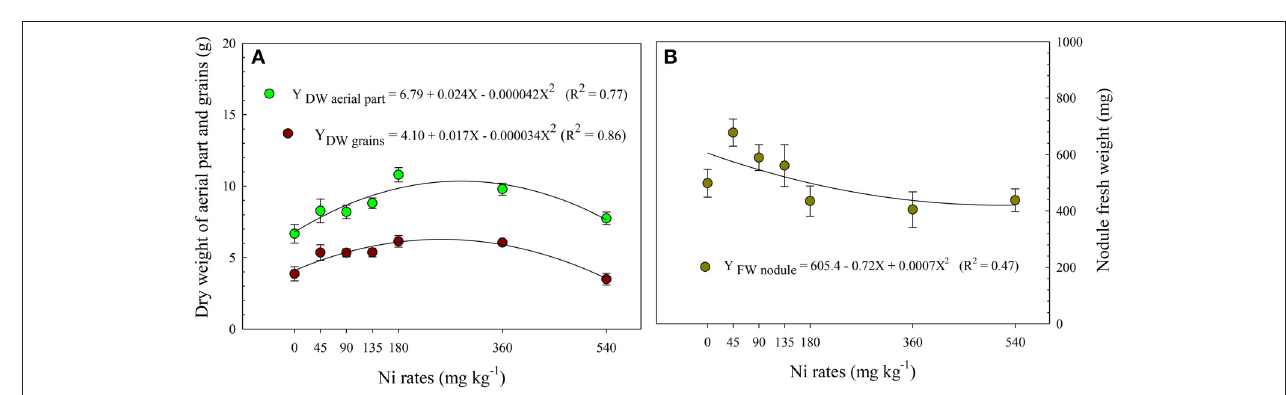
FIGURE 5 | Dry weight of aerial parts and grains (A) and fresh weight of nodules (B) of soybean cultivar BMX Potência RR as related to Ni seed treatments (rates). The nodules were collected at R1 phenological stage (Fehr et al., 1971), while aerial parts and grains were collected at phenological stage R7. The average was computed of four replicates per treatment. Mean ± SD. (Fisher Test, p < 0.01 ).